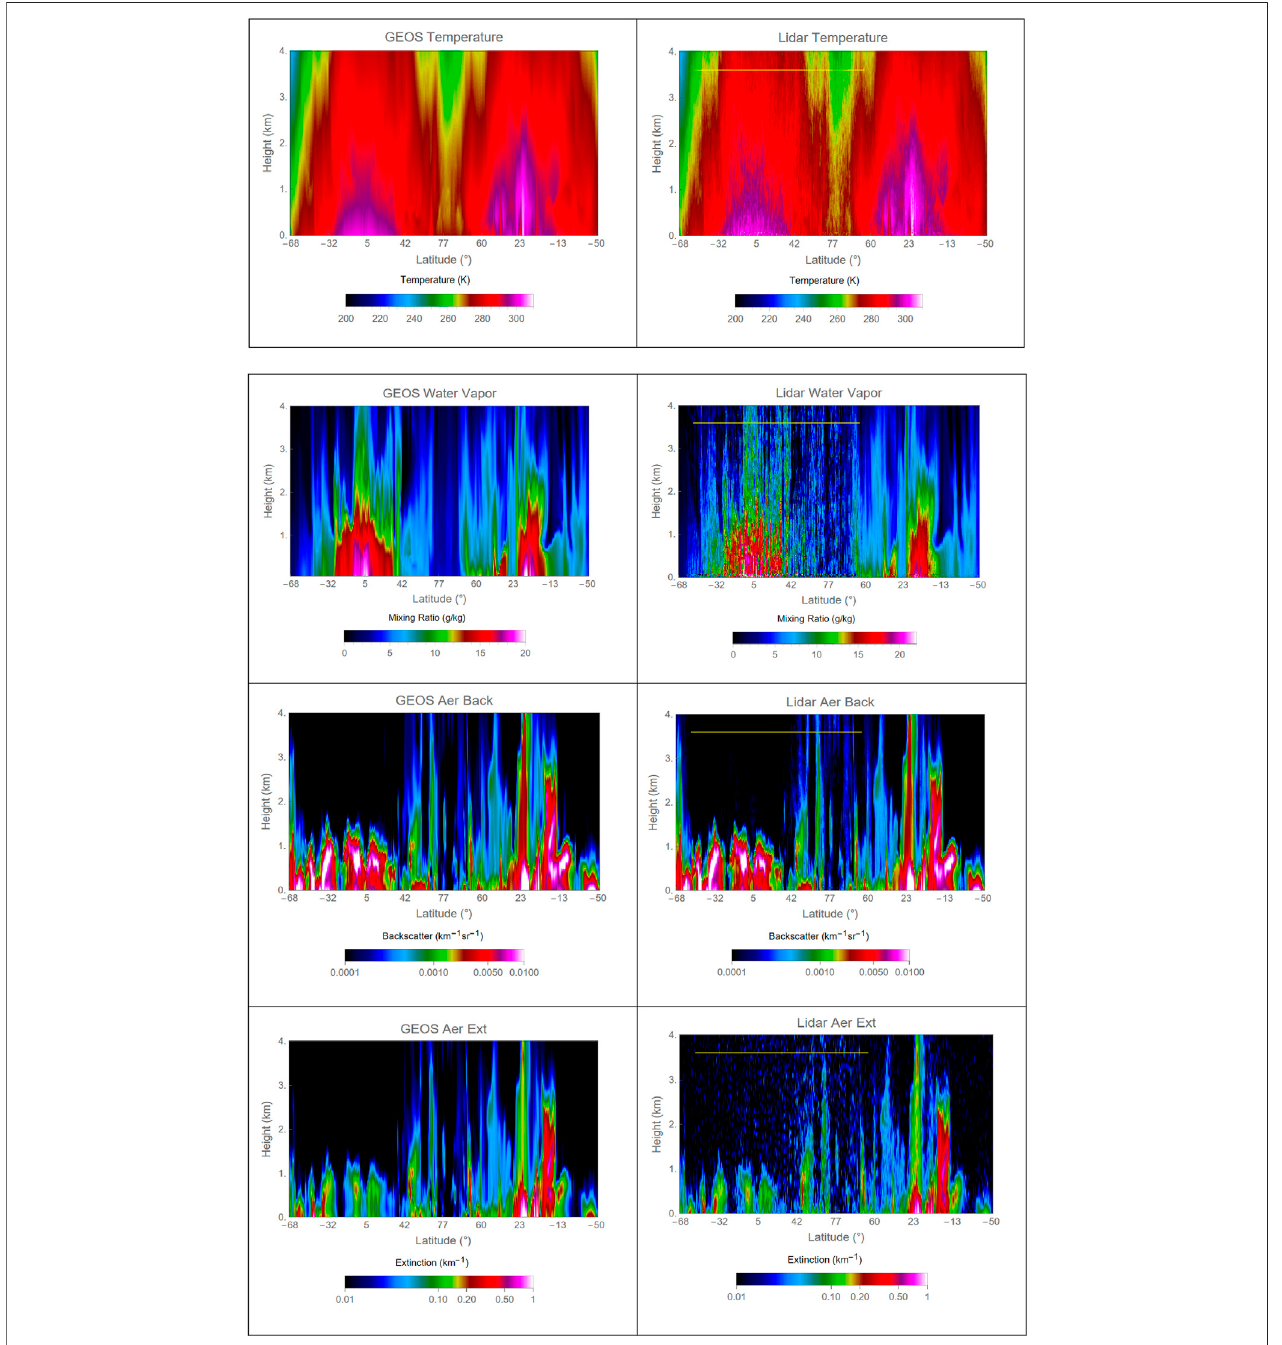
FIGURE2| ComparisonofGEOSinputandlidarsimulationsforapproximately1.25 hofthe24 hCALISPOorbit.Theplotsextendtoanaltitudeof4 kmconsistent with the focus on lidar performance within the PBL. The portion of the image where the sun is above the horizon is shown with a yellow line in the upper left of the lidar images. See text for further